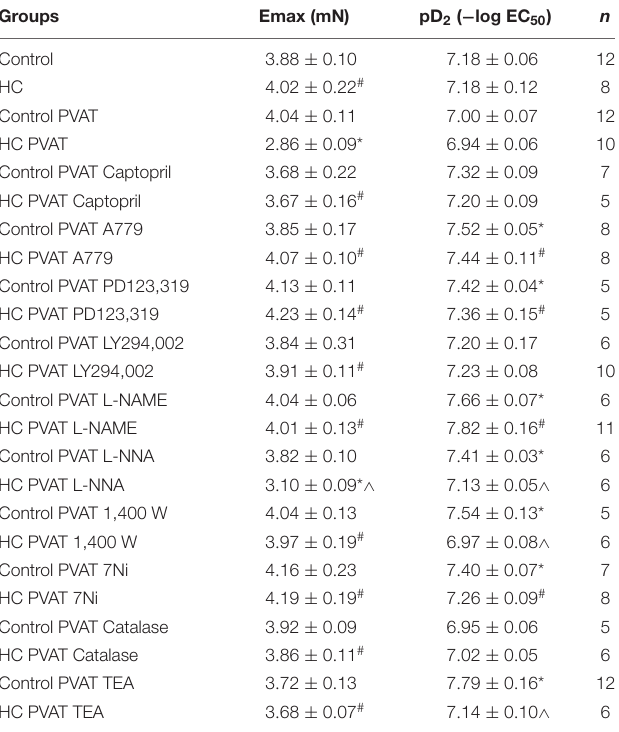
TABLE 3 | Emax and pD 2 values of vascular contraction induced by PE in intact thoracic aortas in the presence or absence of PVAT, previously incubated or not with the specified